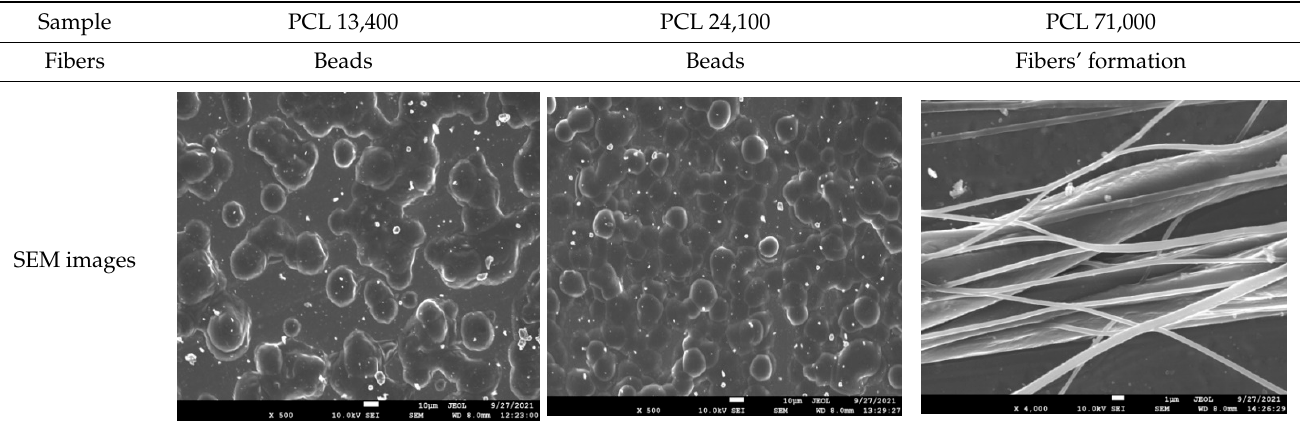
Table 4. SEM images presenting the effect of concentration of the polymer solution on the electro- spun structure of PCL with 71,000 g/mol. Concentration of PCL 71,000 g/mol in Chloroform (% w/v )